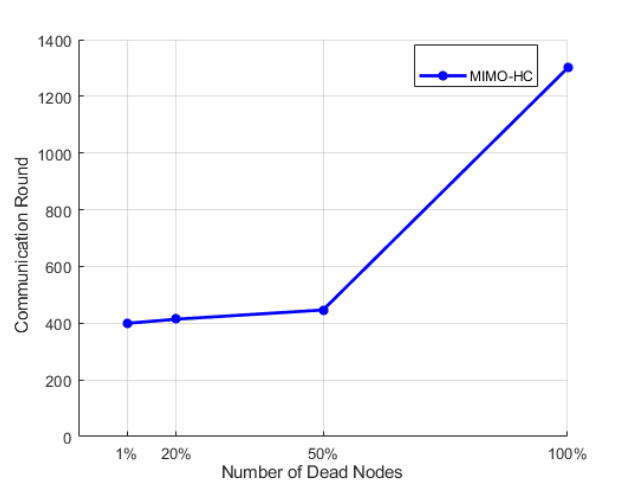
Figure 14. Performance results for 300 nodes in a 200 m × 200 m